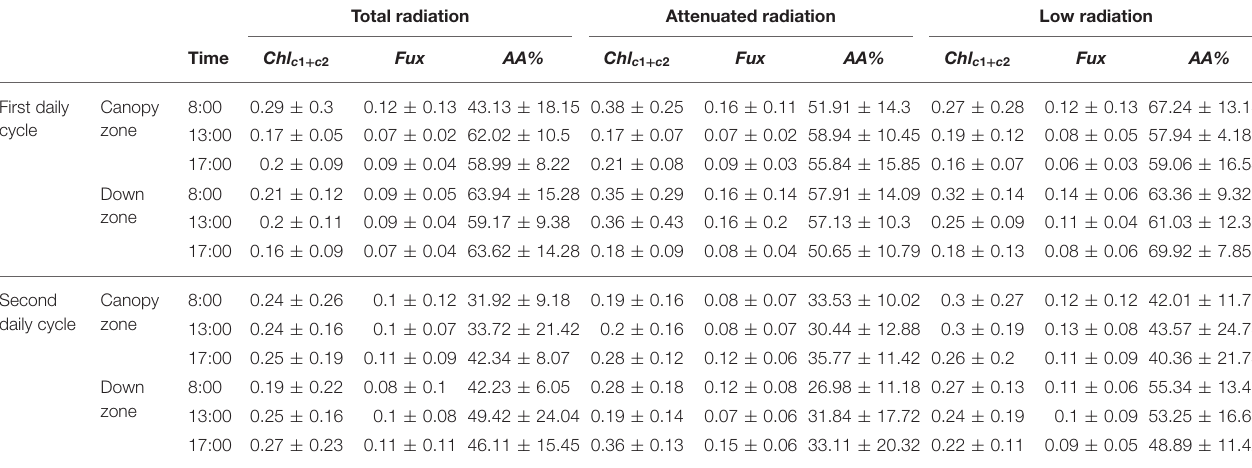
The pigments contents and AA% were determined in two different zones of the thalli (canopy and down zones) (mean ± SE, n = 3).